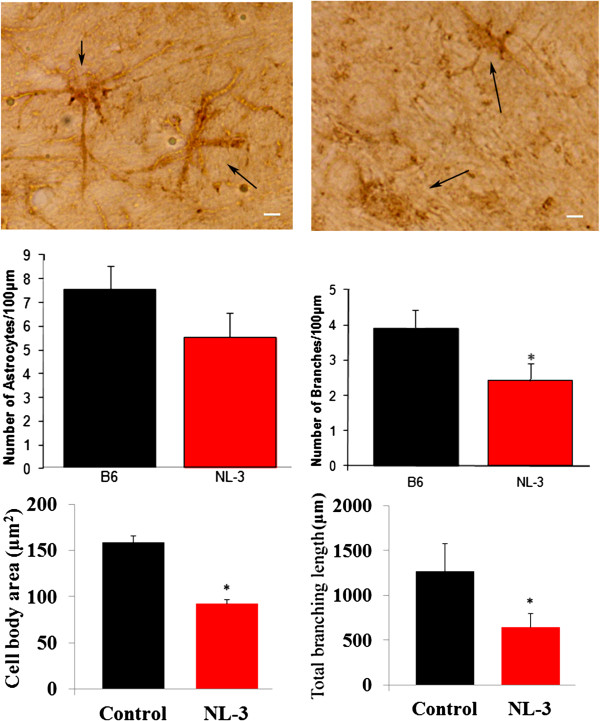
The morphology of astrocytes was altered in the frontal cortex of NL3 knockdown mice. Immunohistochemistry studies were carried out on the whole brain sections from one NL3 knockdown mouse and one age-matched control littermate using an anti-glial fibrillary acidic protein (GFAP) antibody (dilution 1:1000). Immunostaining of GFAP (dark brown color) was present in all astrocytes. The density of astrocytes from the frontal cortex, as well as the number of astrocytic branch processes, cell body size and the total branch length were quantified using Image J analysis. *P < 0.05. Scale bar: 10 μm. Data are shown as mean ± standard error (SE).